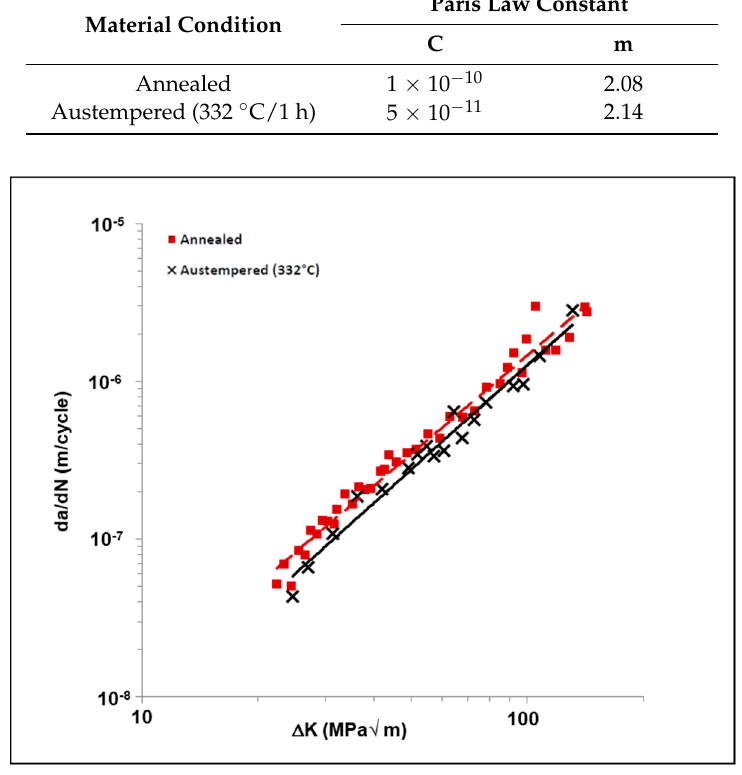
Figure 6. The Effect of Austempering on the Fatigue Crack Growth Rate of Uncharged 4140 Steel in the Linear Region.